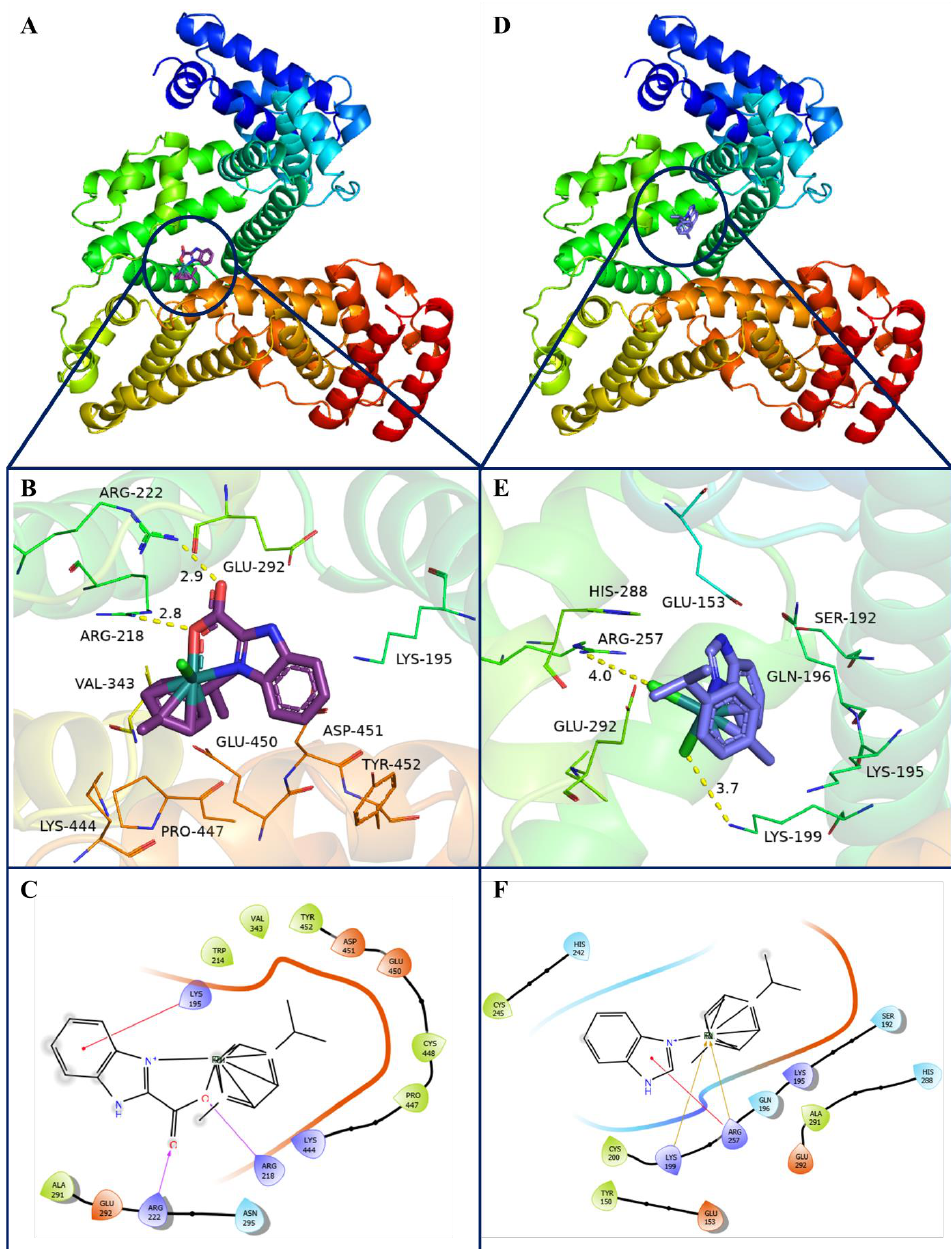
Figure 8. The best-scored poses obtained by molecular docking experiments for HSA with Ru(II) complex 1 ( A ) and Ru(II) complex 2 ( D ). HSA residues involved in forming interactions with compounds 1 and 2 are shown in panels ( B , E ), respectively. Furthermore, 2D ligand – protein interactions plots were generated for HSA with compound 1 's( C ) and compound 2 's ( F ) best poses.